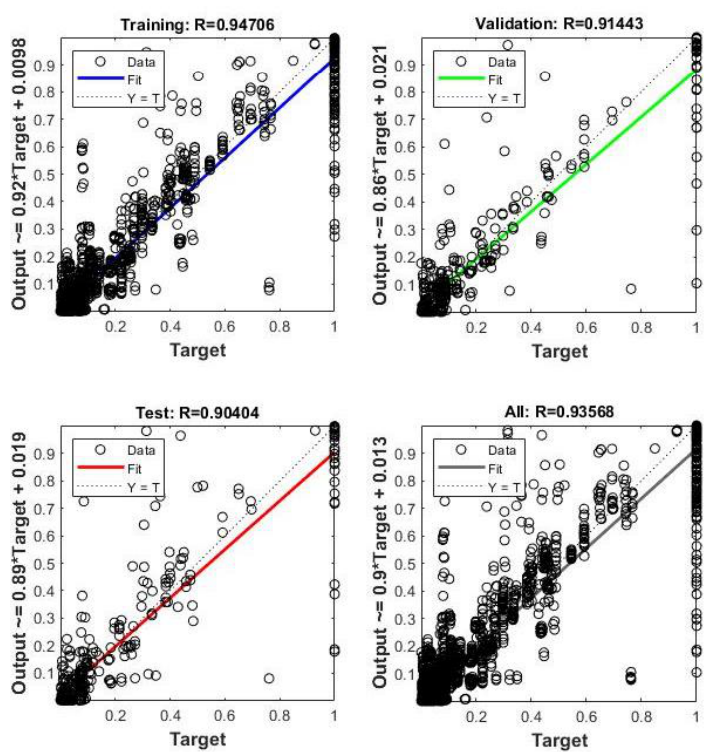
Figure 8. R values of the Training, Validation, and Test of ANN for acceleration output.